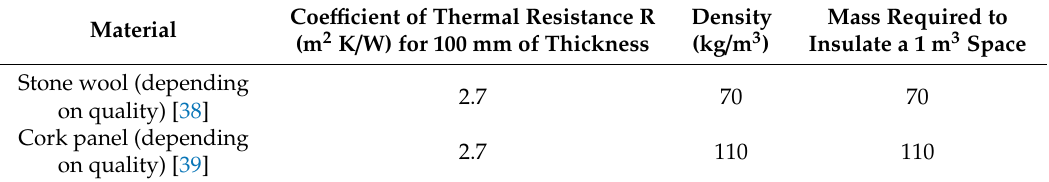
Table 3. Comparison of materials for a biomimetic architectural project to obtain the same thermal insulation performance R.